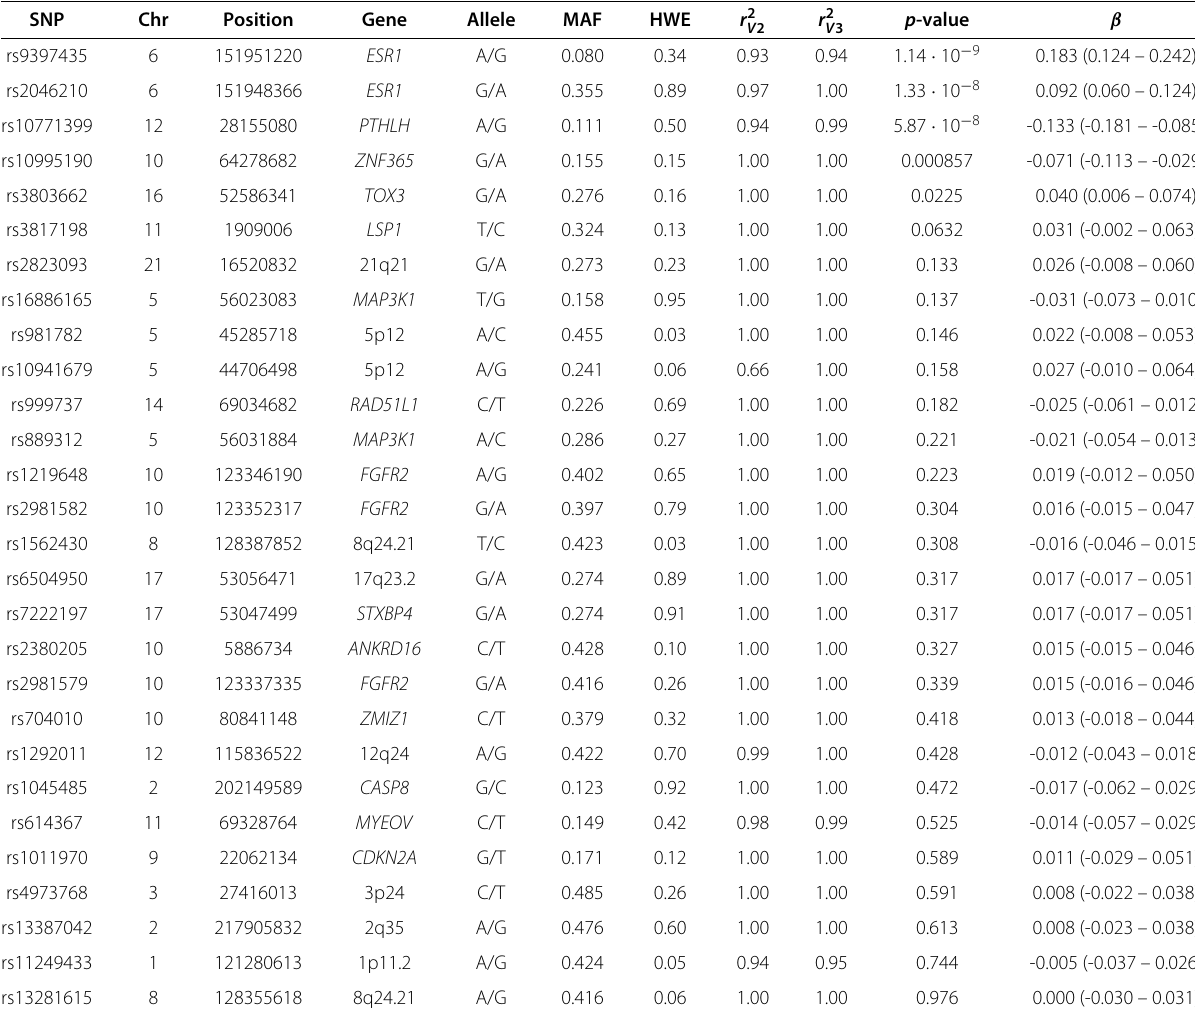
Table 2 Association with breast size for SNPs previously associated with breast cancer SNP Chr